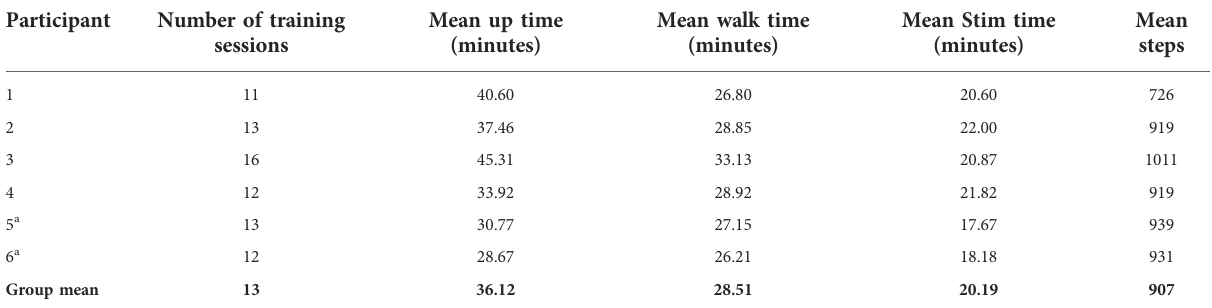
TABLE 2 Intervention training metrics for study